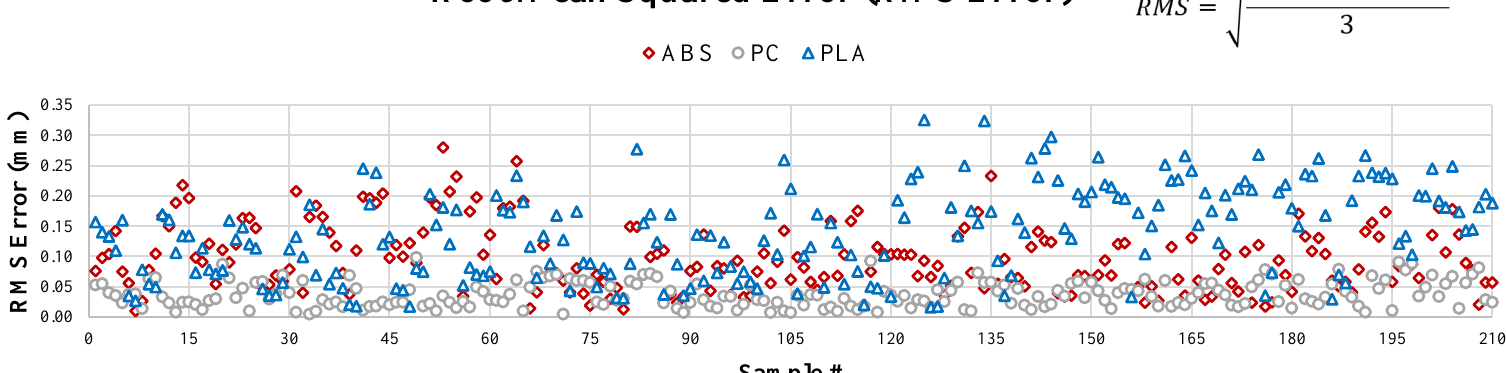
Figure 17. True vs. nominal dimensions for Z, C, and E as well as the root mean squared error